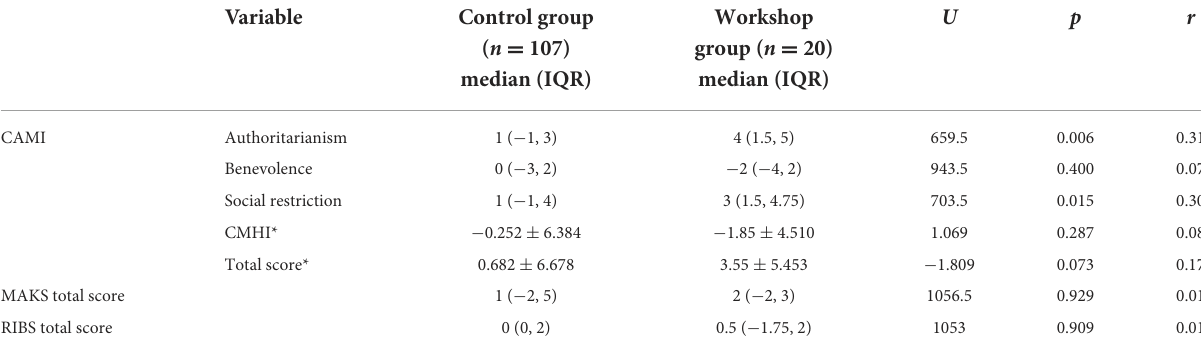
TABLE 4 Between-group comparison for changes in